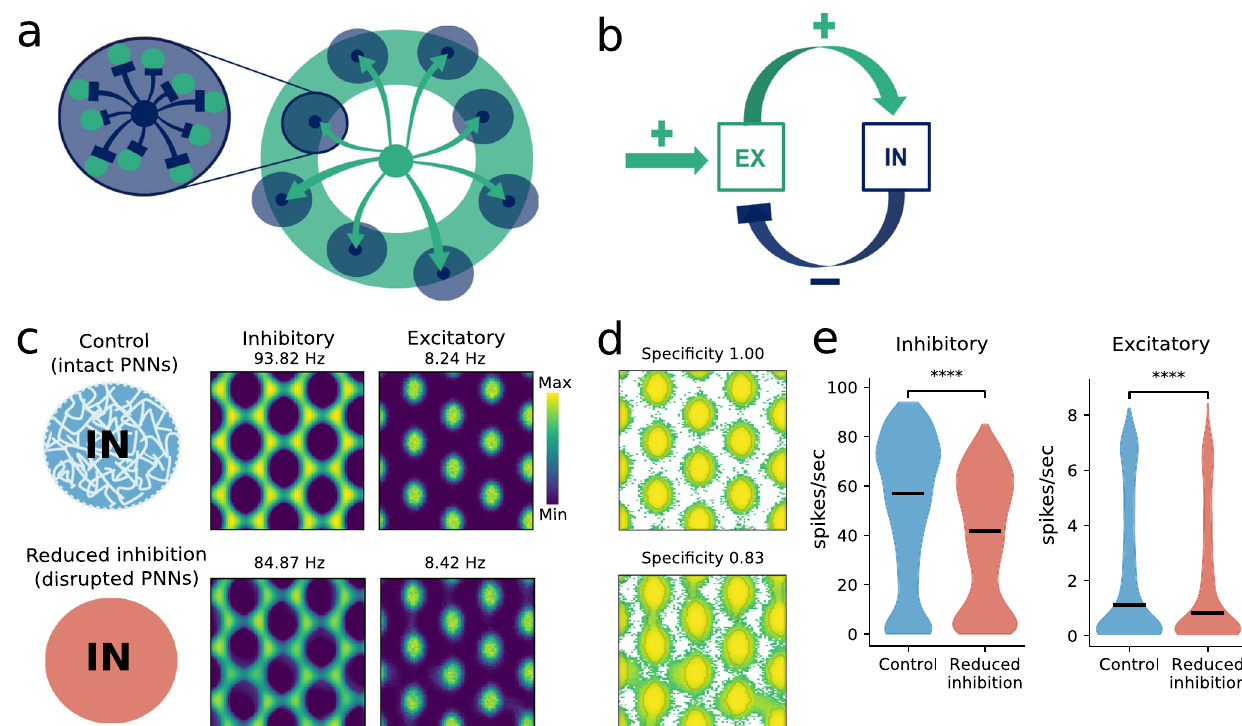
Fig. 6 Continuous attractor model of the grid cell network with altered inhibition. a Schematic outline of the model. Each excitatory unit (green) is connected to distant inhibitory neurons (dark blue), which in turn inhibit excitatory neurons locally. b A population of excitatory neurons (EX) receive external excitatory drive and feedback inhibition by a population of inhibitory neurons (IN). c PNN removal was simulated by reducing the excitatory to inhibitory synaptic strength (lower panel). Rate maps of excitatory neurons show grid pattern for both control and the reduced inhibition network. d The grid cells in the reduced inhibition network show increased out-of- fi eld rate and thereby lower speci fi city than control, as seen with logarithmic color scale. Note the increased number of green spikes representing rate outside the fi eld. e The average fi ring rate of both inhibitory and excitatory neurons are lower in the reduced inhibition network (median, inhibitory control: 57; inhibitory reduced inhibition: 41.7; U = 29,940,515, n = 6858 and excitatory control: 1.11; excitatory reduced inhibition: 0.82; U = 15,509,839.5, n = 5398, p < 0.0001, Mann – Whitney U test (two sided)). Source data are provided as a Source Data fi